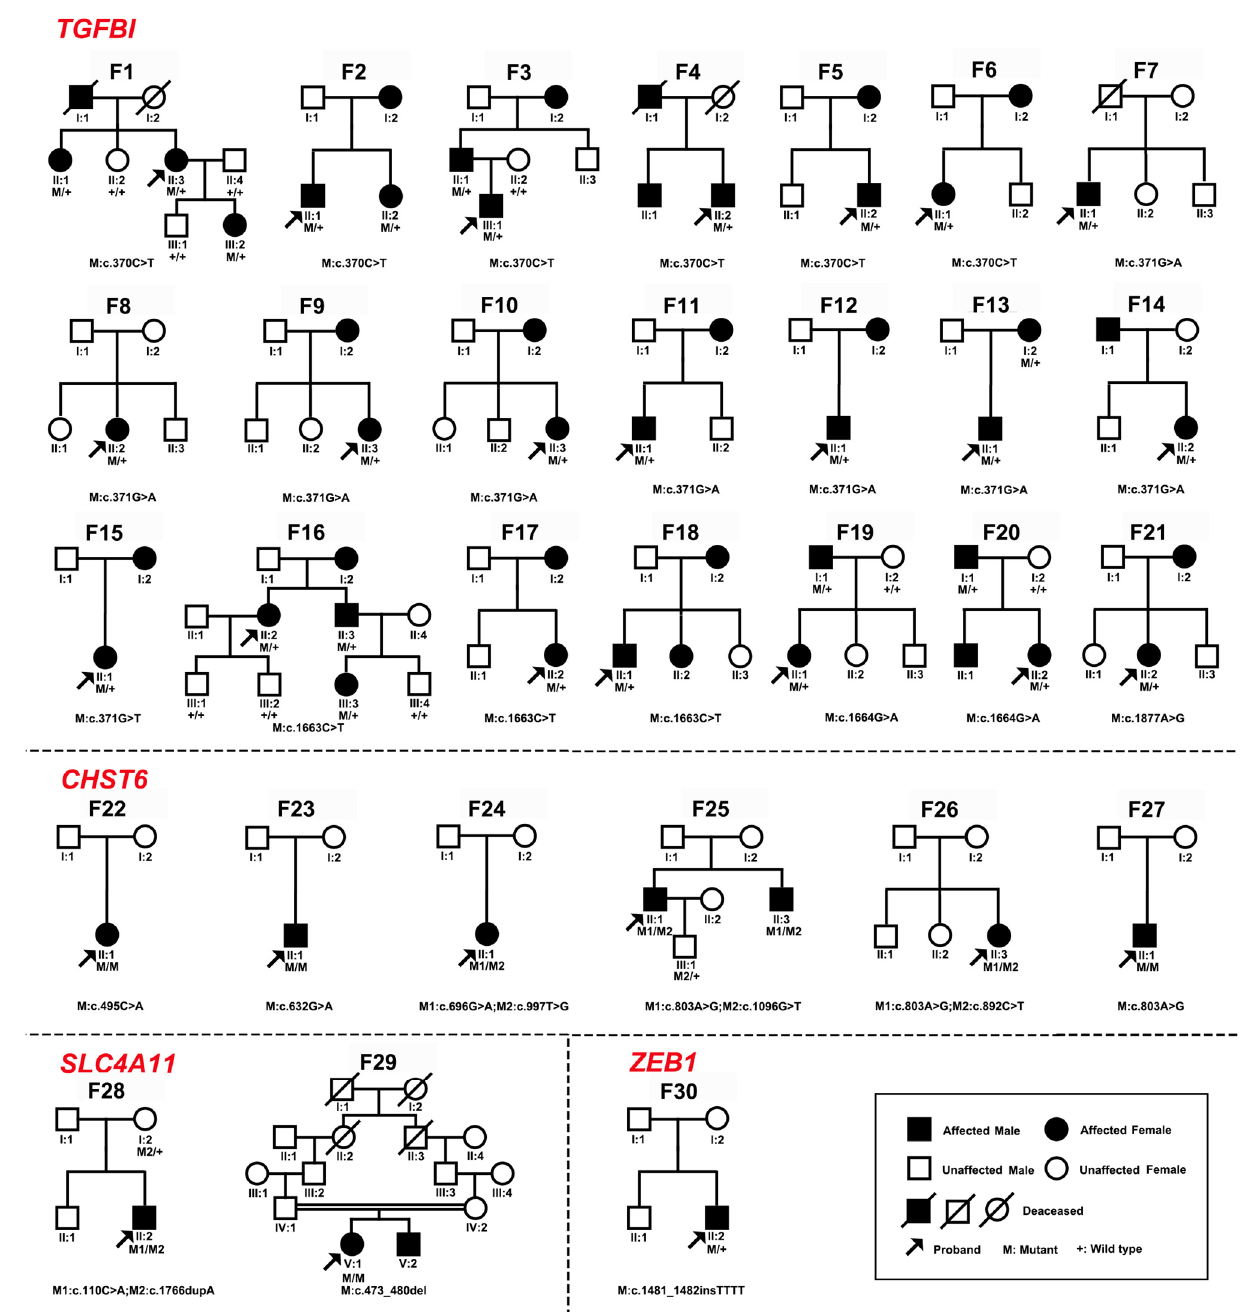
Figure 1. The pedigrees of 30 families with pathogenic or likely pathogenic variants in TGFBI, CHST6 , SLC4A11 , or ZEB1 of CDs in our cohort. The variants of the probands and family members are provided below the pedigrees. M indicates the mutant allele; + indicates the wild-type allele.